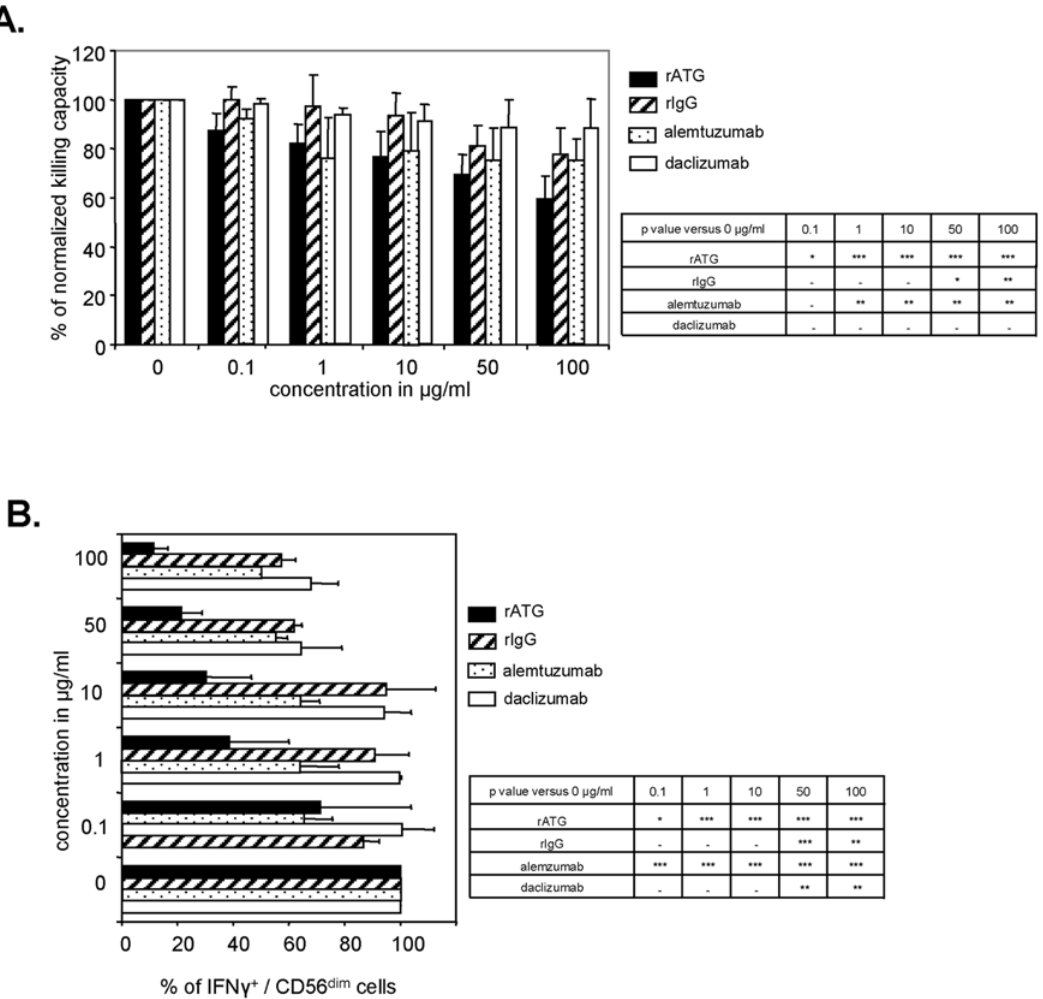
Figure 3. Rabbit ATG and alemtuzumab decrease effector mechanisms of peripheral blood CD3 2 CD56 dim NK cells. (A) Dose- dependent decrease of NK cell cytotoxicity after 18 hours pretreatment with rATG, alemtuzumab, daclizumab and rIgG (0–100 m g). Killing assay for viable and antibody-depleted NK cells was performed using the target cell line K562 (E/T ratio was 10:1). Analysis of six independent experiments was performed by flow cytometry. Values demonstrate results normalized to untreated cells, which were set at 100%. Asterisks (*) indicate values that showed significantly less cytotoxicity compared to control: *p , 0.05, **p , 0.01, ***p , 0.001. (B) K562 cells (E/T ratio 2:1) were added to NK cells cultured for 18 hours with IL-2 (200 IU/ml) and varying concentrations of rATG, alemtuzumab, daclizumab and rIgG. Cells were harvested, stained and analysis was performed for CD3 2 CD56 dim IFN c + NK cells. Values demonstrate the mean of INF c + /CD56 dim NK cells normalized to untreated cells, which were set at 100%. Results are displayed as means 6 SD for 6 independent experiments. Asterisks (*) indicate values that showed significantly less IFN c expression compared to untreated controls: *p , 0.05, **p , 0.01, ***p , 0.001.